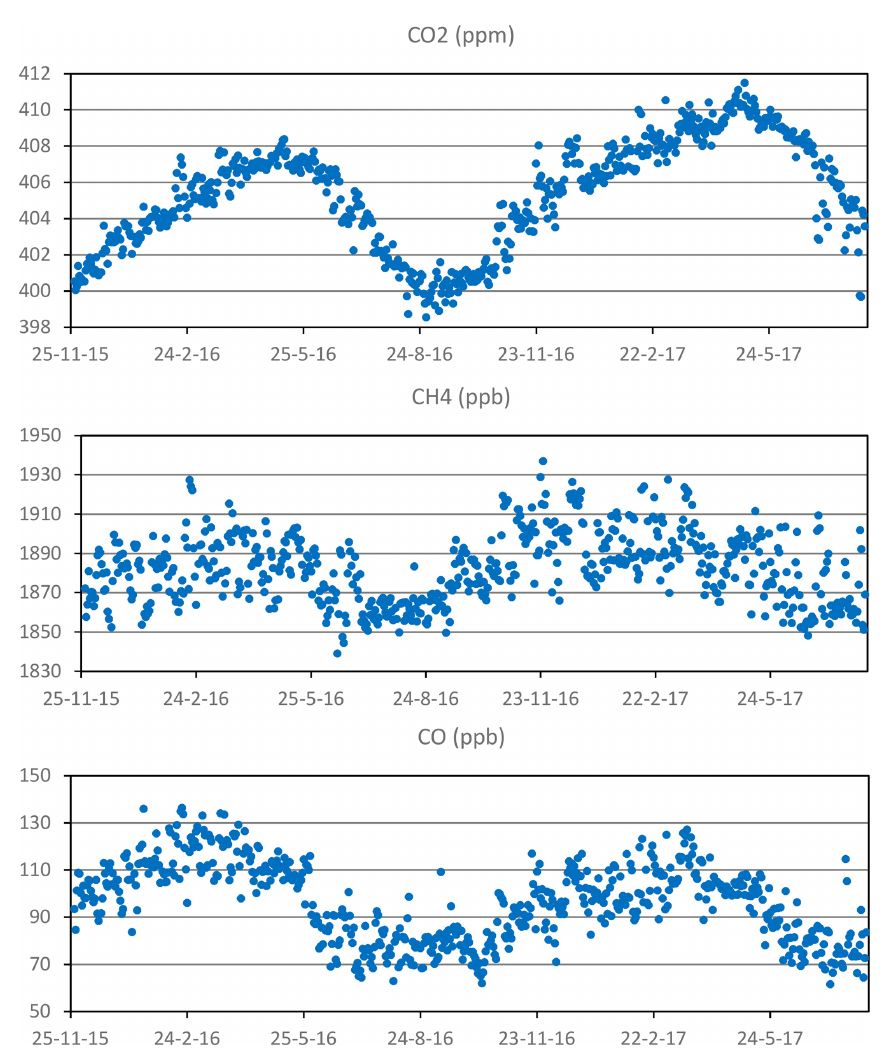
Figure 15. Time series of daily-nighttime (12h averages) CRDS measurements (CO 2 , CH 4 and CO).